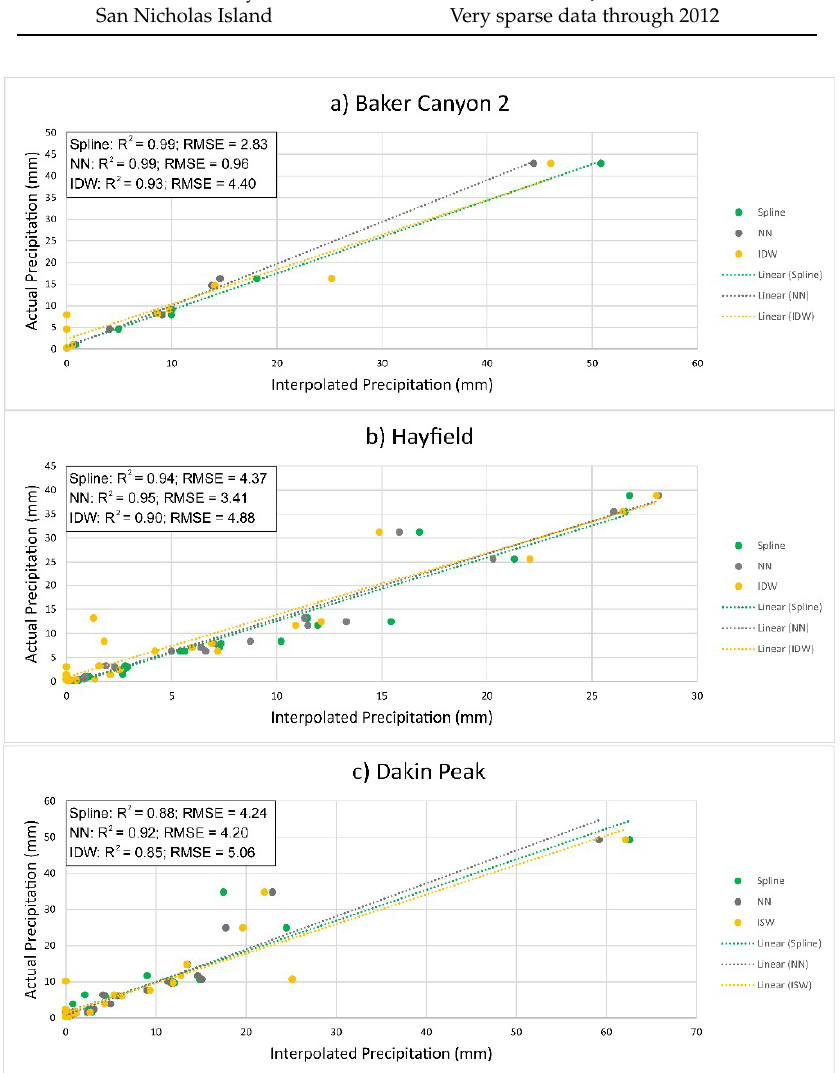
Figure 2. Linear regression analysis of spline, natural neighbor (NN), and inverse distance weighting (IDW) precipitation interpolation at Baker Canyon 2 ( a ), Hayfield ( b ), and Dakin Peak ( c ) climate stations. Data shown represents rainfall events for 2008. Climate stations were selected for the analysis because they exhibited the least amount of missing data.